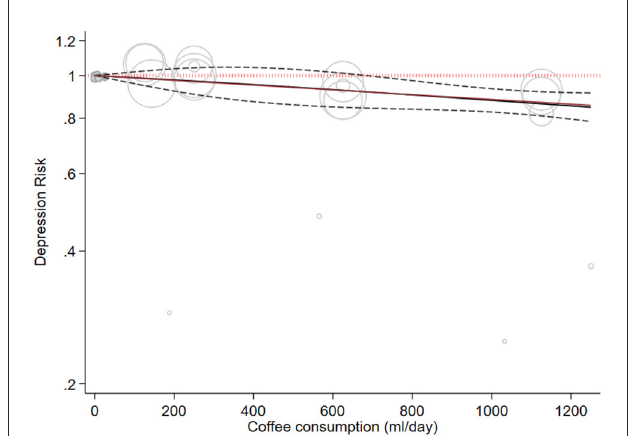
FIGURE2 Dose-response association between coffee intake and depressive symptoms. The solid line represents a non-linear dose response, and the dotted lines represent a 95% confidence interval. Circles represent hazard ratio point estimates for coffee intake categories from each study with circle size proportional to the inverse of standard error.